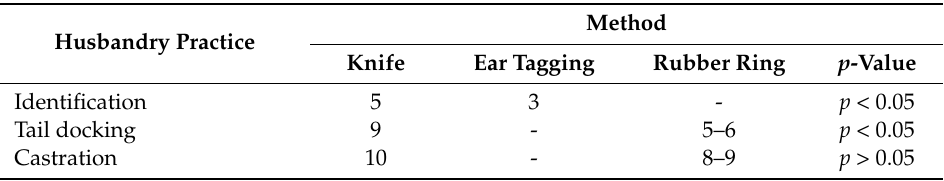
Table 3. Median numerical rating scale pain scores perceived by sheep farmers according to husbandry practice and method used.